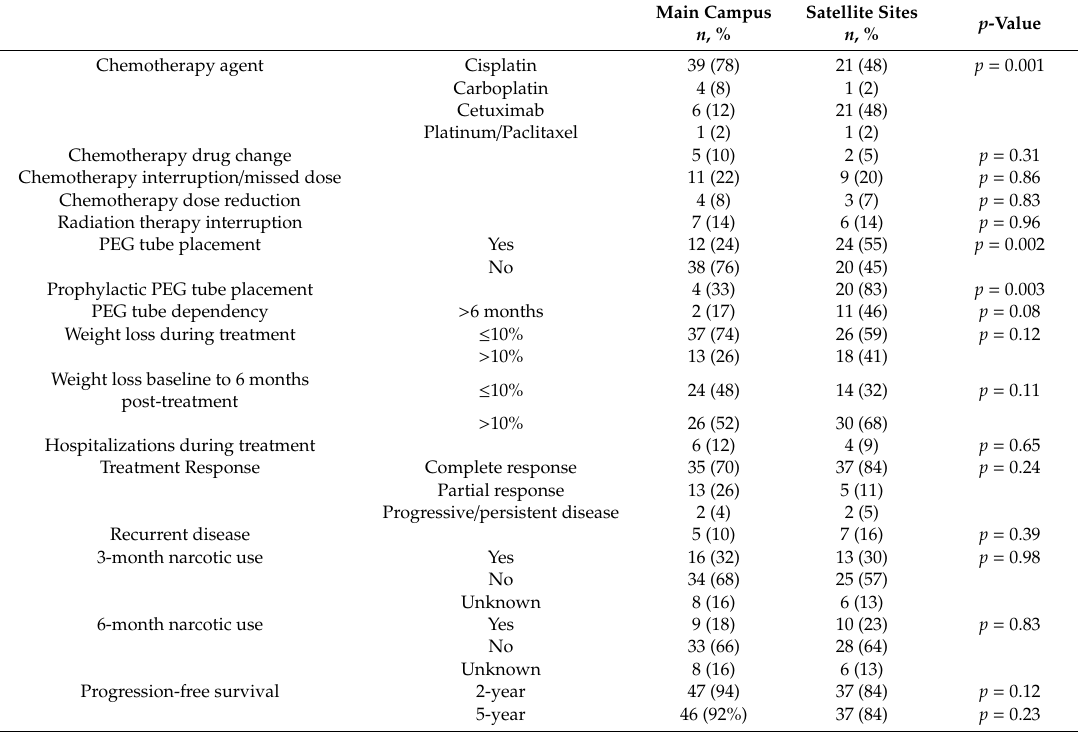
Table 2. Treatment and functional